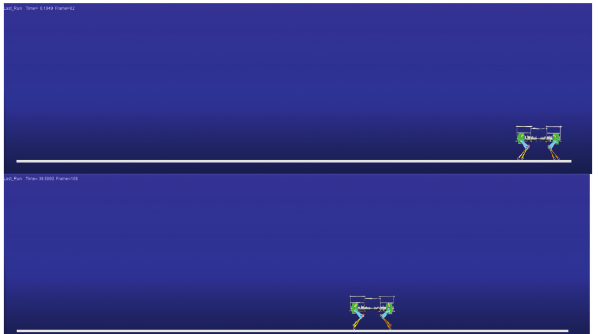
Figure 18: Starting and ending point of the robot simulation.